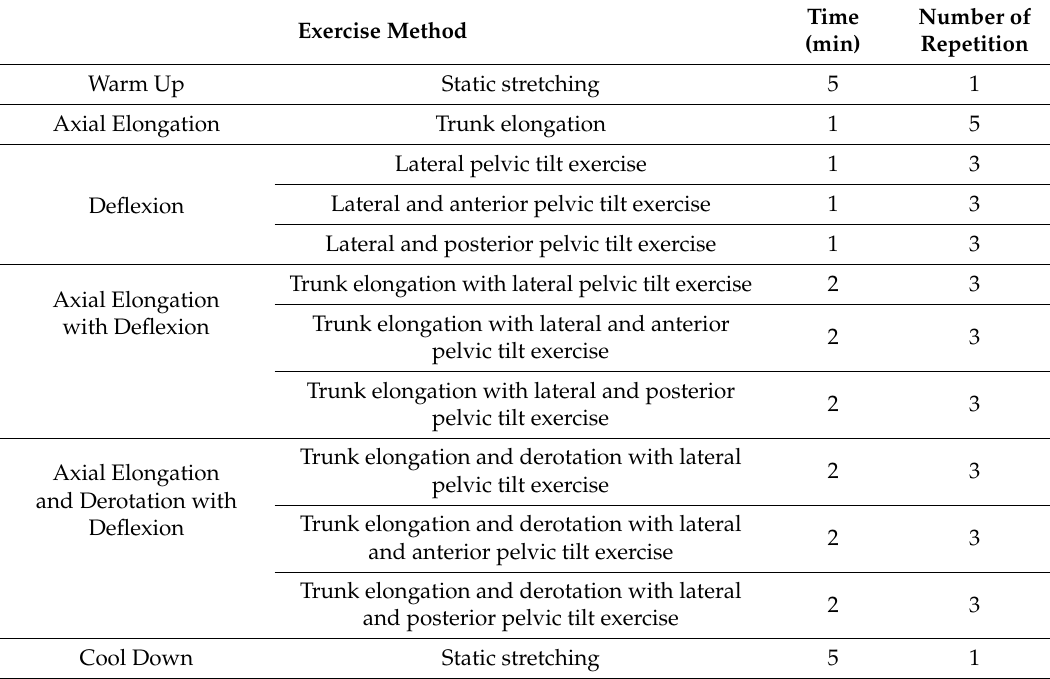
Table 1. Protocols for personalized exercise